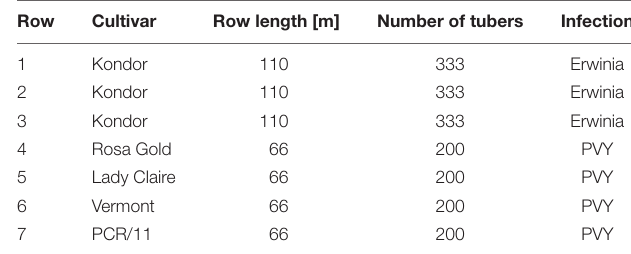
TABLE 1 | Description of the test